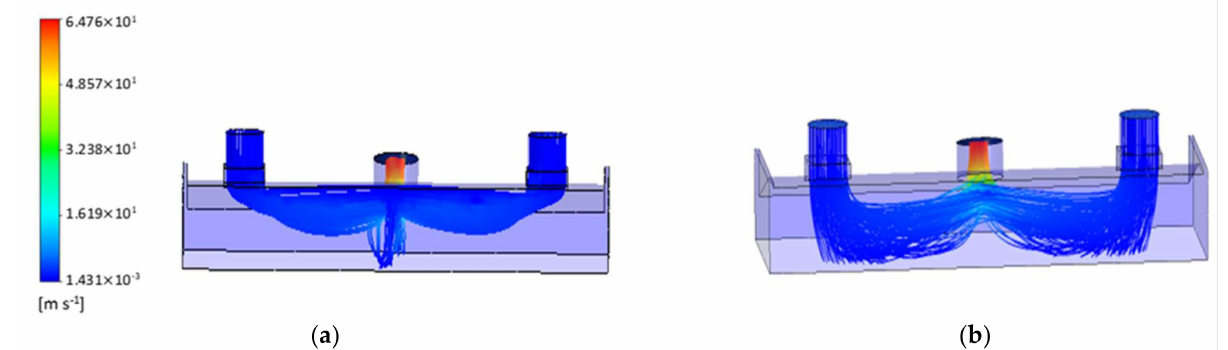
Figure 7. The results of simulating the effect of changes in particle composition on recirculated flow and particle motion in the system. ( a ) Wood-volatiles dust; ( b ) Aluminum-solid dust.